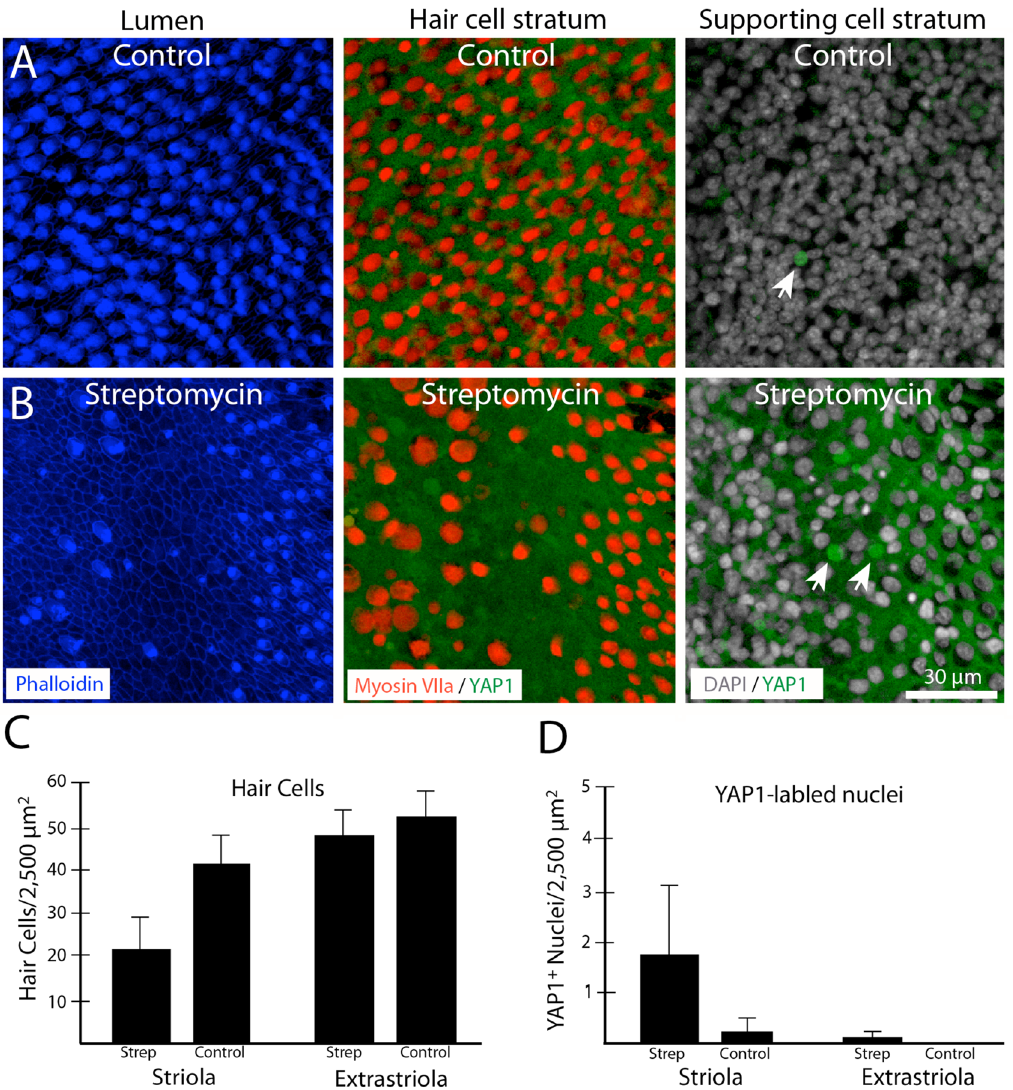
Figure 6. Localization of YAP1 in the chick utricle. ( A ) Labeling of an undamaged utricle with phalloidin (blue) shows numerous stereocilia (left) and hair cells (red, labeled for myosin VIIa) surrounded by YAP1- expressing supporting cells (green) (middle). We also observed a few supporting cell nuclei with nuclear YAP1 (arrow) in undamaged (control) utricles. ( B ) Three days of systemic treatment with streptomycin (1200 mg/kg) caused a partial loss of hair cells that was limited to the striolar region. This region of hair cell loss also contained increased numbers of supporting cells with nuclear immunoreactivity for YAP1. ( C , D ) Quantification of hair cells and YAP-labeled nuclei in streptomycin-treated and control utricles. Streptomycin treatment resulted in hair cell loss and increased YAP1-labeled nuclei in the striolar region (t-test, p = 0.016). In contrast, the extrastriolar region was not affected by the streptomycin treatment ( C ) and did not contain enhanced numbers of YAP1-labeled nuclei ( D